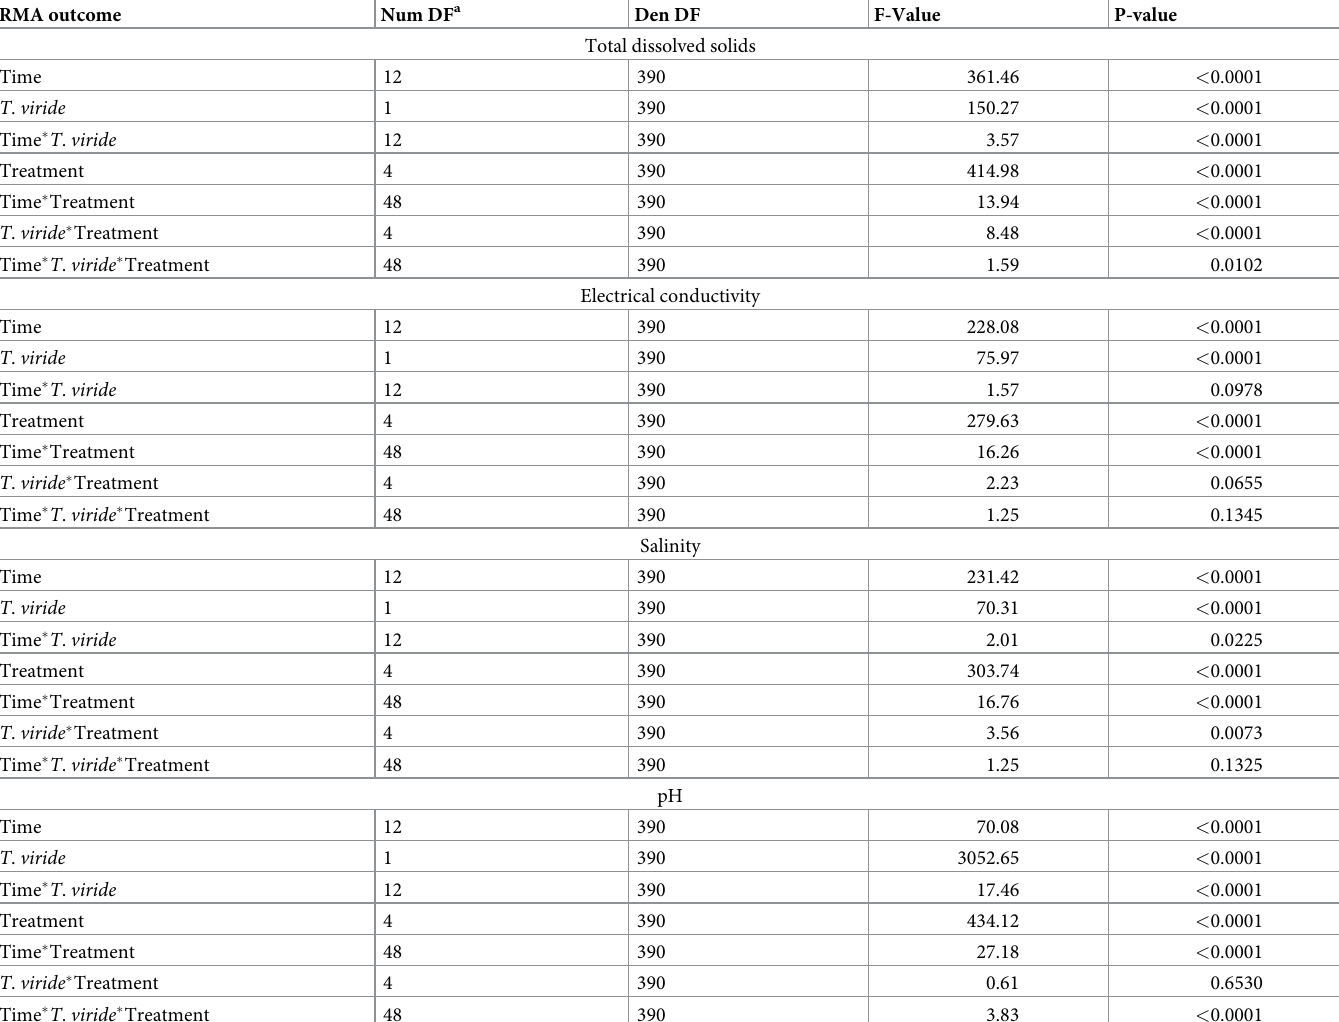
Table 3. Repeated measures analysis (RMA) for total dissolved solids, electrical conductivity, salinity and pH for vermicast-sawdust mixed media without (A) and with (B) Trichoderma viride in the nutrient release